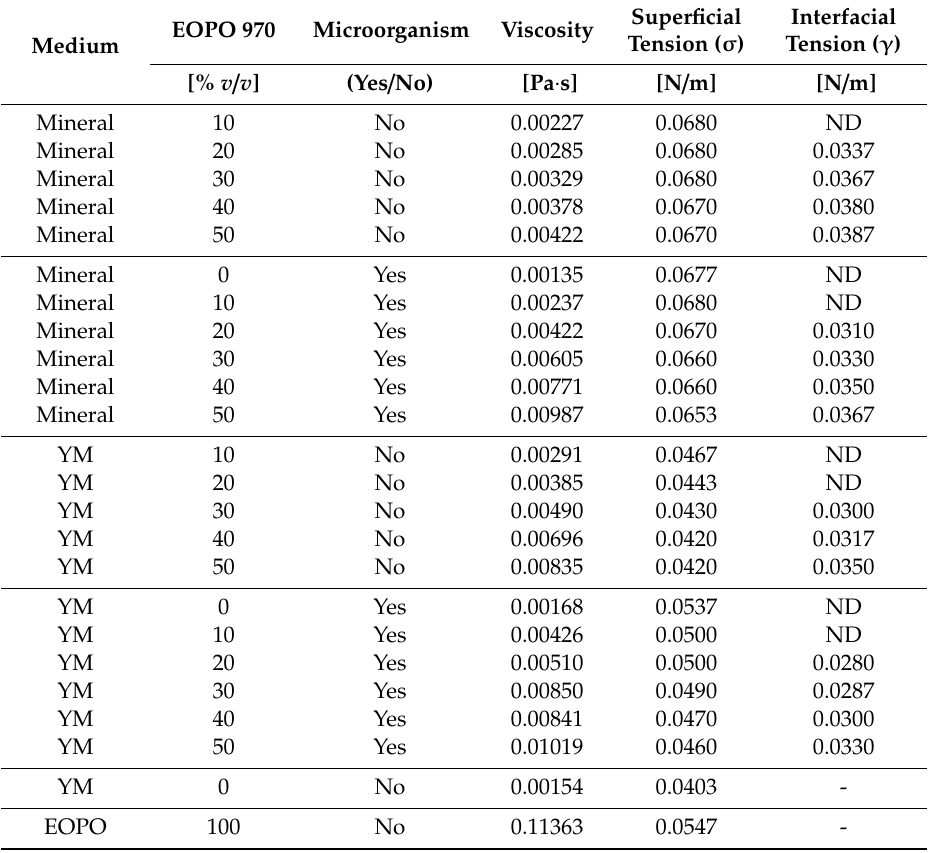
Table 4. Two-phase system property